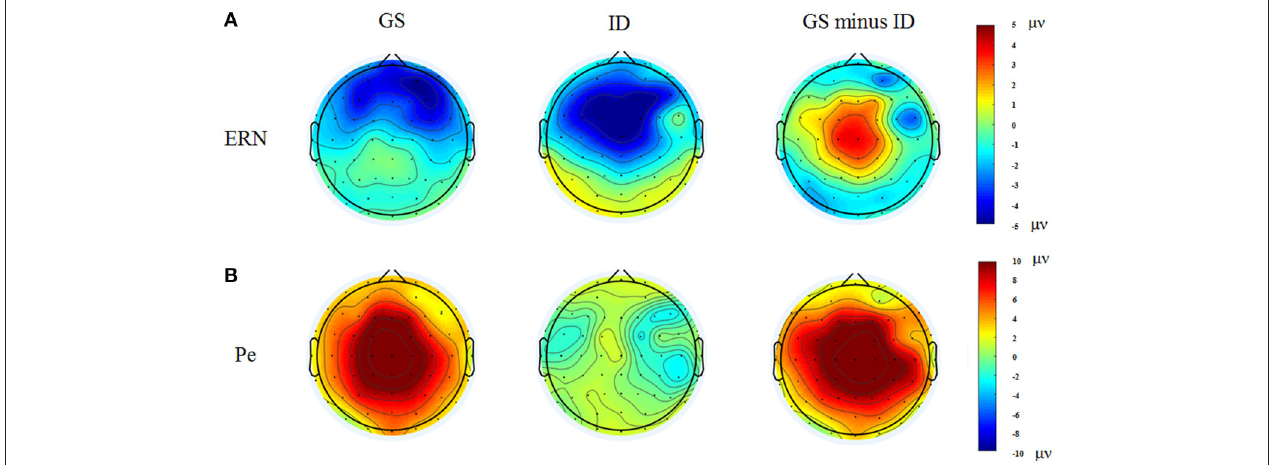
FIGURE 6 | Topographic maps of the ERN (0–100ms, A ) and Pe (150–300ms, B ) components time-locked to button press in the failed stop trials. Left: Topographic maps of each ERP component for the group of good sleepers (GS). Middle: Topographic maps of each ERP component for the group of insomnia disorders (ID). Right: Topographic maps of each ERP component for the GS minus